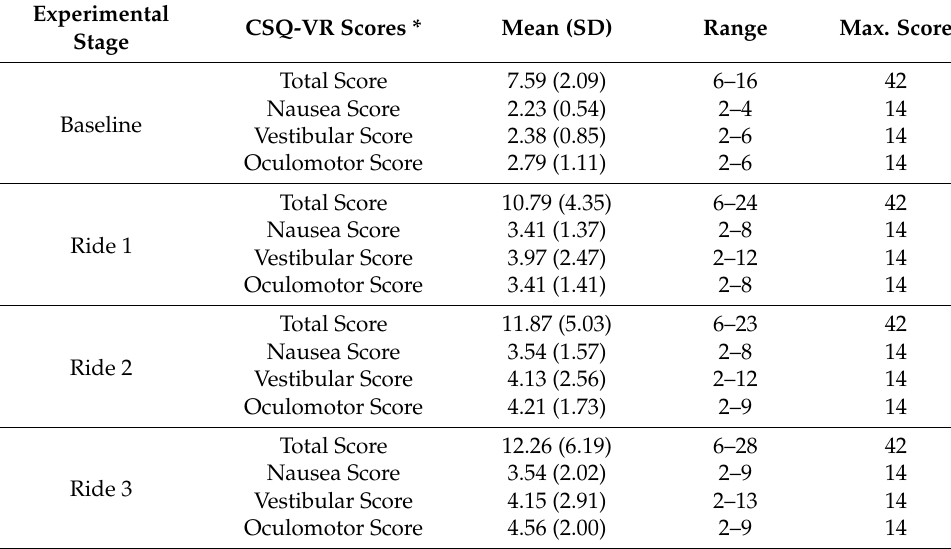
Table 2. Descriptive Statistics of the VR version of CSQ-VR per Experimental